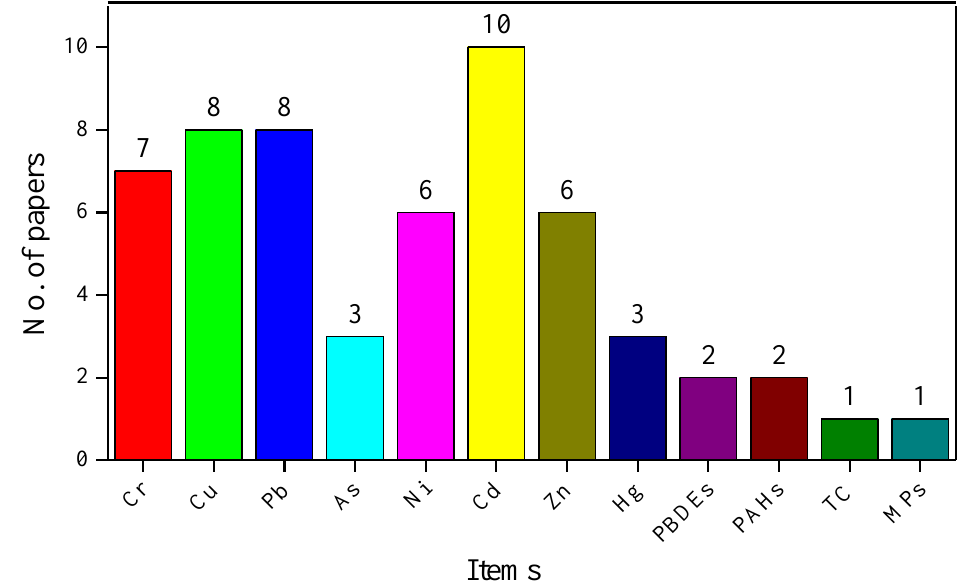
Figure 2. The investigated items of research in the Processes Special Issue: Advances in Remediation of Contaminated